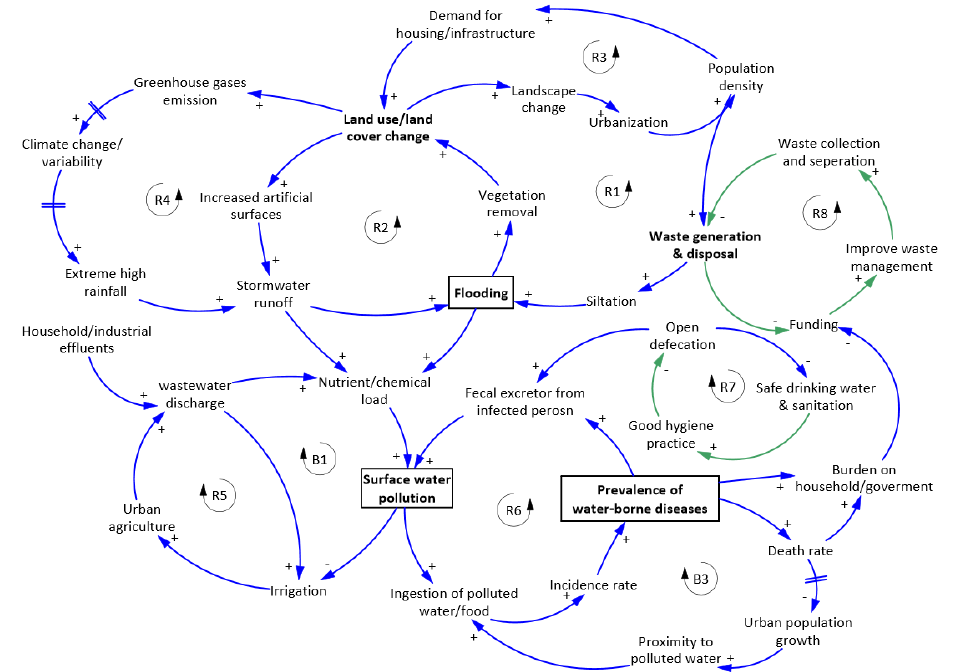
Figure 9. Integrated CLD obtained from the key feedback loops in the sub-models developed. The blue arrows show the connections between the variables, while the green arrows indicate interventions altering the state of these variables. Source: based on primary data collection in the Odaw River catchment in Ghana, in April 2019.